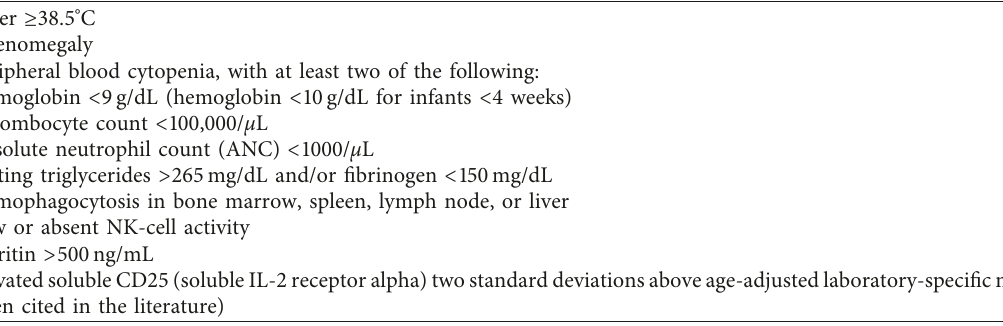
Table 1: Diagnostic criteria for HLH ∗